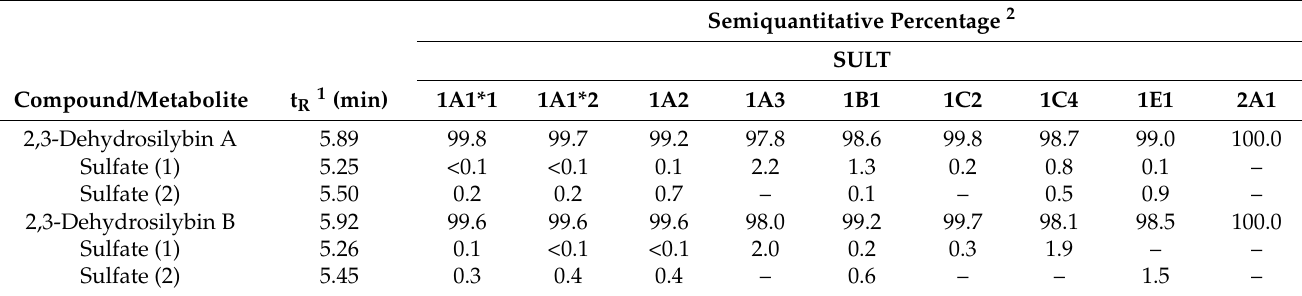
Table 3. Sulfation of 2,3-dehydrosilybin A and 2,3-dehydrosilybin B by human